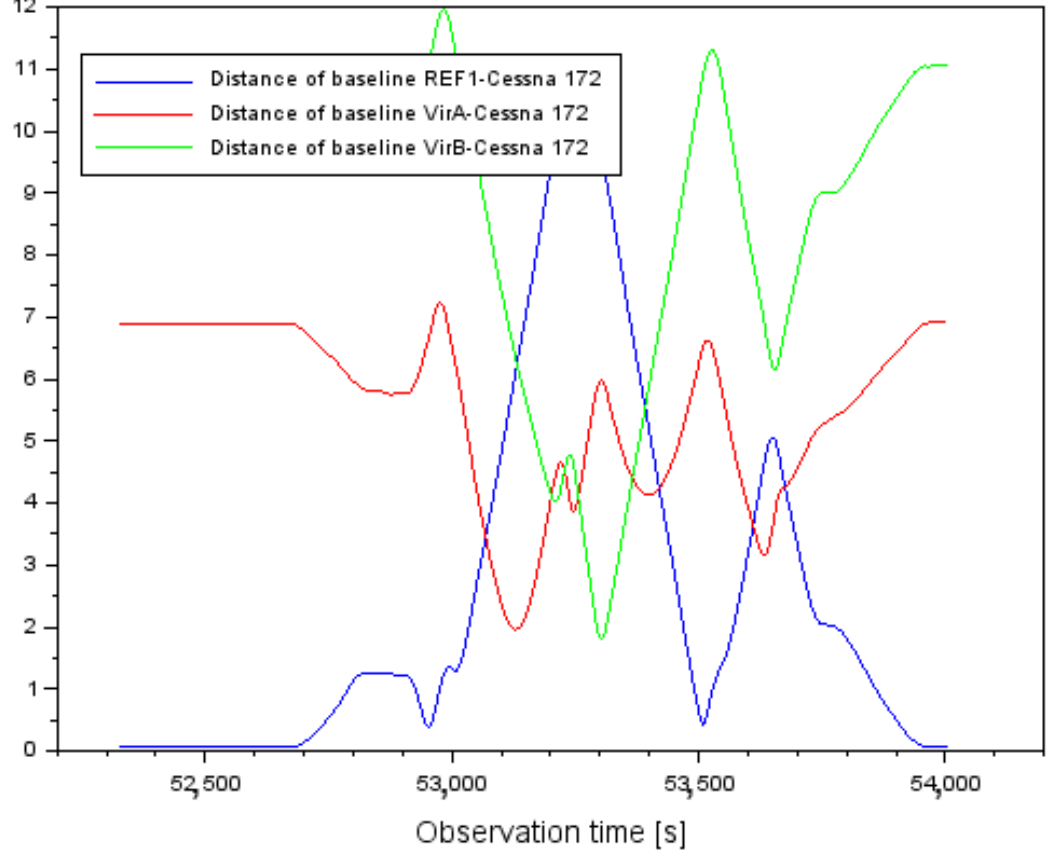
Figure 1. Distance of baselines between each GPS reference station and Cessna 172 aircraft.